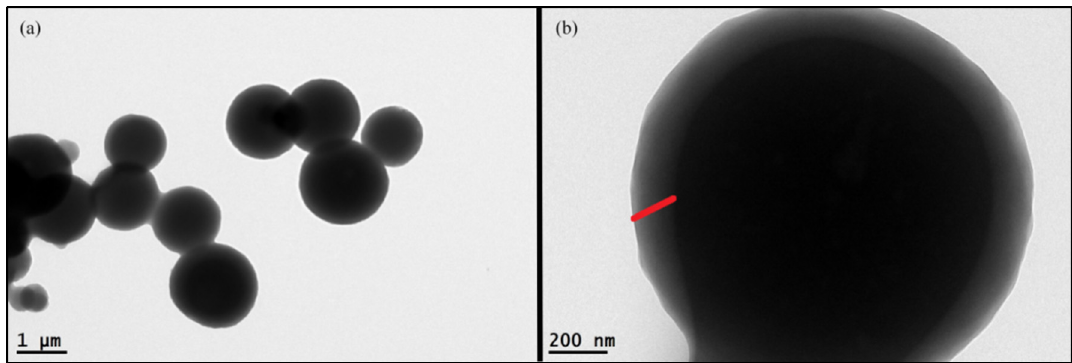
Figure 3. Morphology of the synthesized microcapsules: ( a ) optical microscopy and ( b ) SEM images.